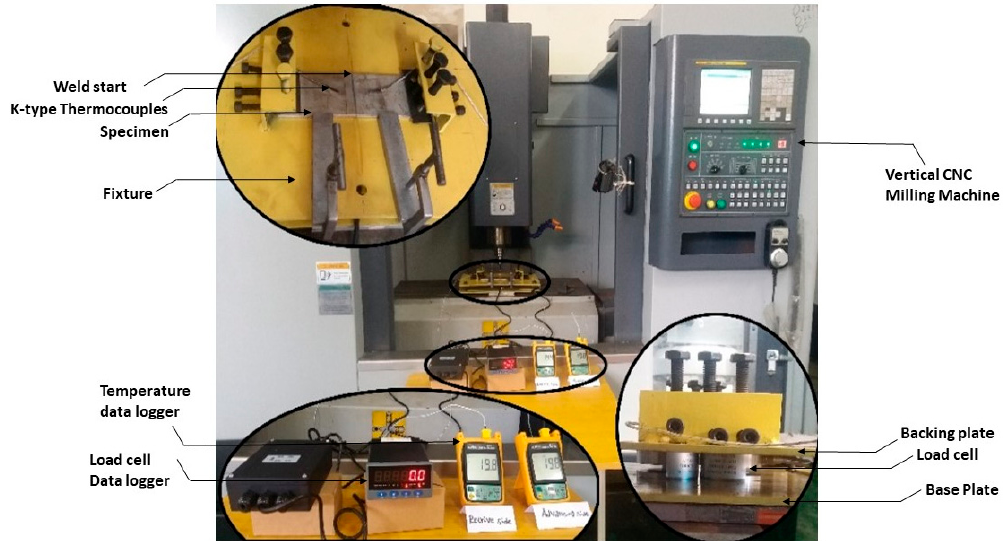
Figure 3. Experimental setup used for FSW connected with the load cell and thermocouples. Table 4. Mechanical properties of H13 tool steel [30,31].